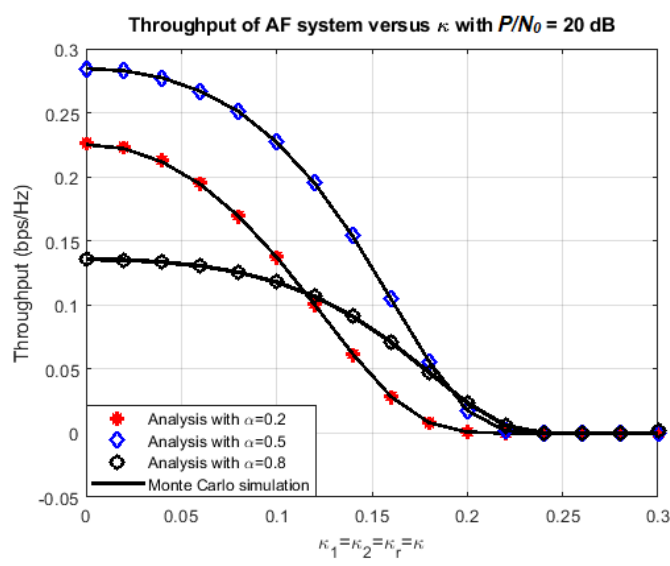
Figure 6. Achievable throughput versus κ .